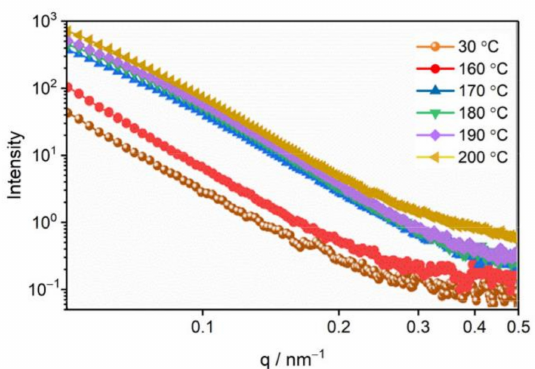
Figure 4. SAXS curves of CL-20 at different temperatures. In order to obtain the change trend of the scattering curve more clearly, the horizontal axis and the longitudinal axis are logarithmic.